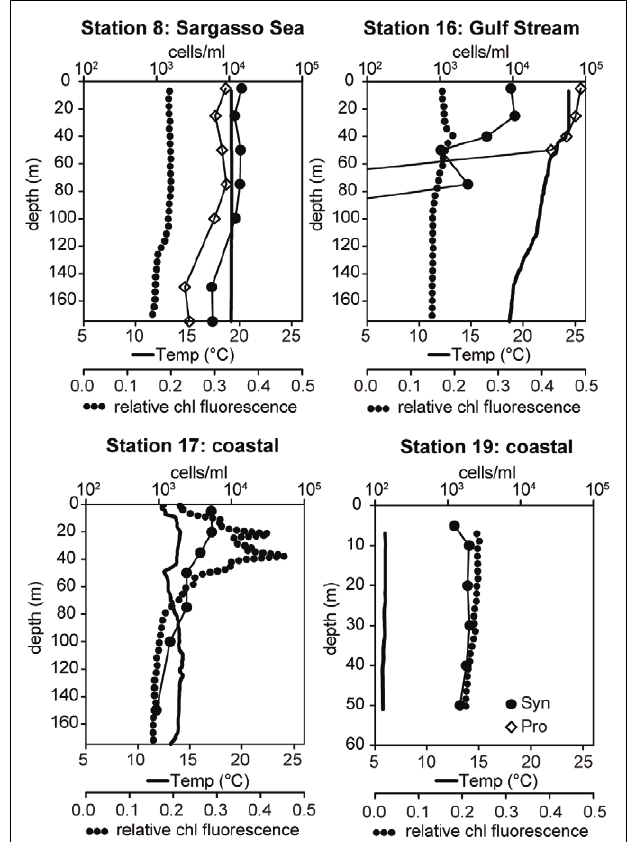
FIGURE 4 |Water column properties of field samples and total Synechococcus (Syn, filled circles) and Prochlorococcus (Pro, open diamonds) concentrations determined by flow cytometry. Water temperature is depicted with solid lines and relative chlorophyll (chl) fluorescence with dotted lines.